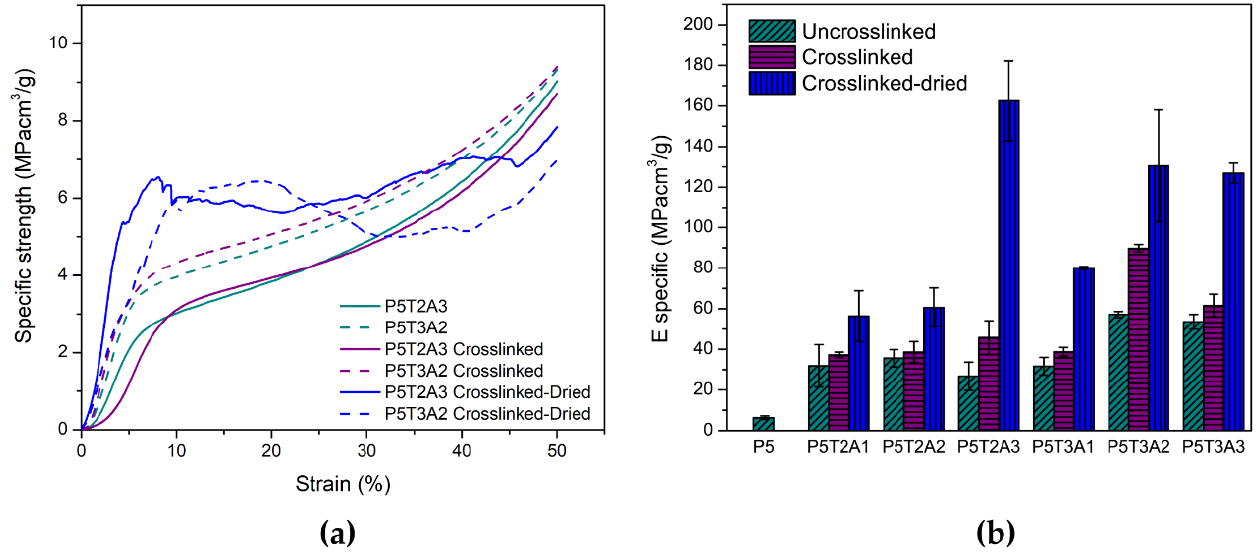
Figure 4. ( a ) Compressive behavior of aerogels; ( b ) comparison of the specific moduli obtained in each composition of aerogels in different states (uncrosslinked, crosslinked, and dried crosslinked). Table 2. Mechanical compressive specific properties of PVA/TA/SA aerogels, with and without crosslinking. Samples crosslinked were tested in both dry and stabilized states. Uncrosslinked Crosslinked Crosslinked-Dried Sample E